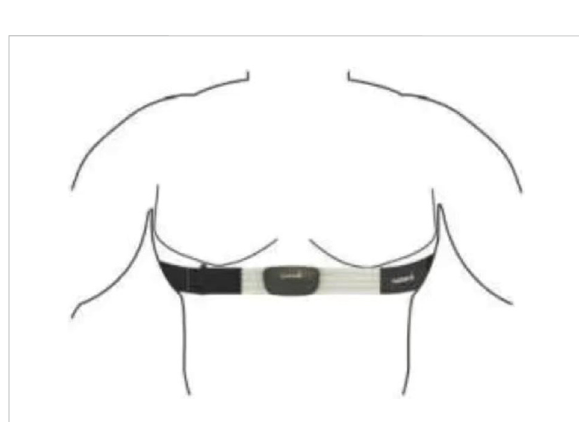
FIGURE 3 FIRSTBEATSPORTSsystemschematicdiagramofthebinding position of the heart rate